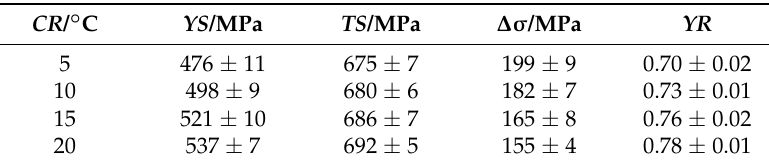
Figure 3. Typical tensile stress-strain curves for different nitrogen content steels. Table 2. Summary of the tensile test results.